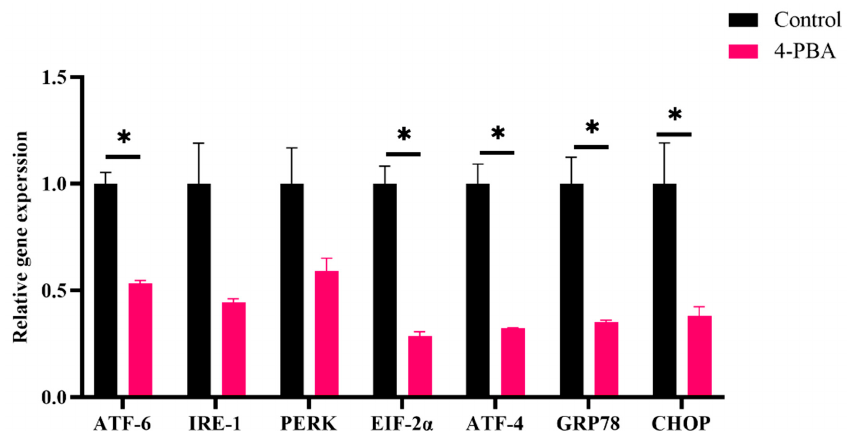
Figure 8. Relative expression levels of ERs-related genes in the livers of L. maculatus after two weeks of being fed the test diets and 48 h of ammonia nitrogen exposure. All values are exhibited as mean ± SE. The values with different superscript (*) are significantly different at p < 0.05 (Student’s t -test).